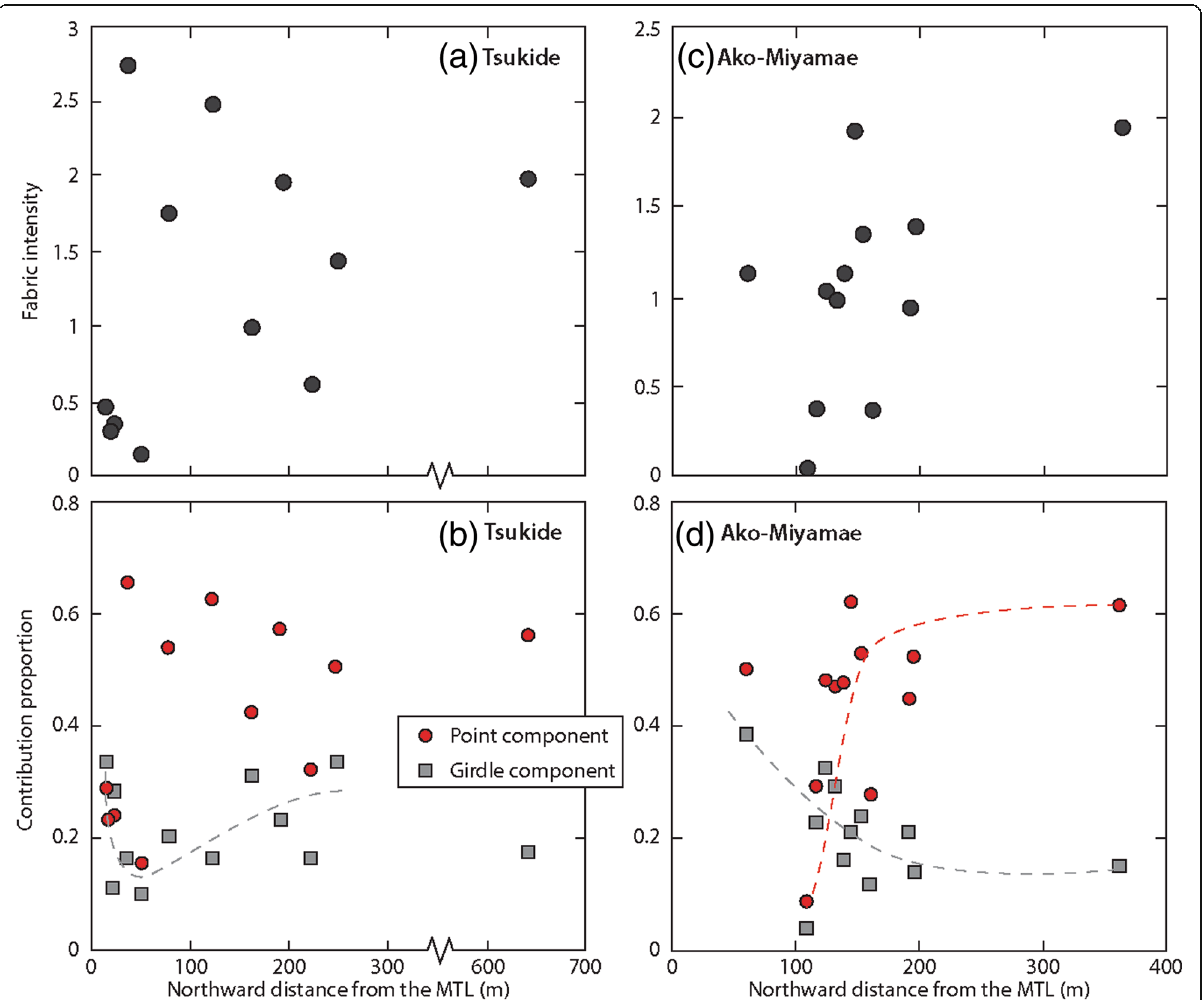
Fig. 10 Variation in quartz [ c ]-axis LPO strength (as indicated by fabric intensity) and the relative proportion of point and girdle components of the LPOs with distance from the MTL in the Tsukide ( a – b ) and Ako – Miyamae ( c – d ) areas. Cluster = S1 – S2, girdle = 2 × (S2 – S3), where S1 – 3 represent the eigenvalues of the normalised orientation tensor (Vollmer